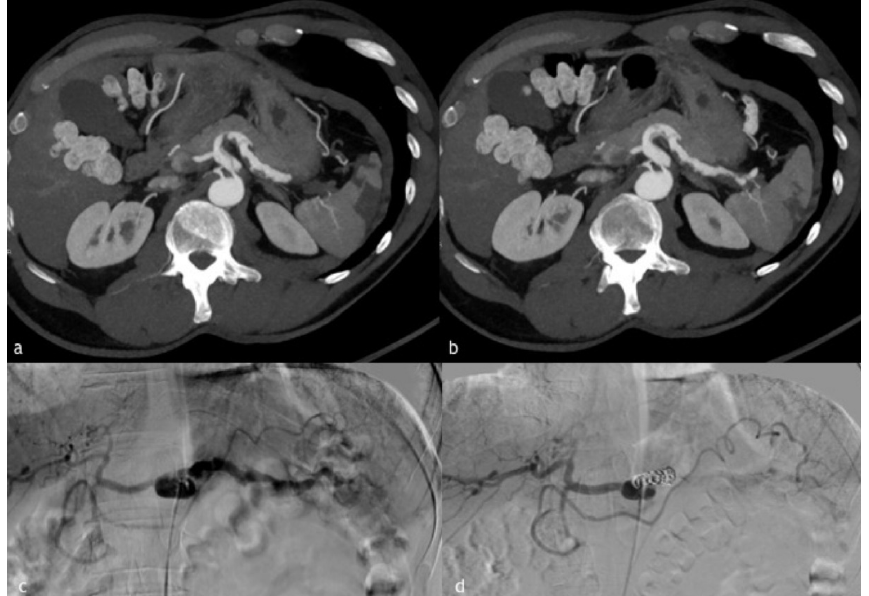
Figure 4. ( a – d ). A 55-year-old man presented to our emergency department for acute abdominal pain. ( a , b ) Axial MIP reconstruction images demonstrate celiac trunk dissection with multiple beading or webs, aspects of the splenic artery suggestive of SAM. ( c ) Digital subtraction angiographic image that shows multiple beading and webs of the splenic artery vessel wall. ( d ) Post-embolization angiographic control, after very proximal embolization for impossibility to more distal catheterization, demonstrating distal recanalization of splenic artery by gastroduodenal